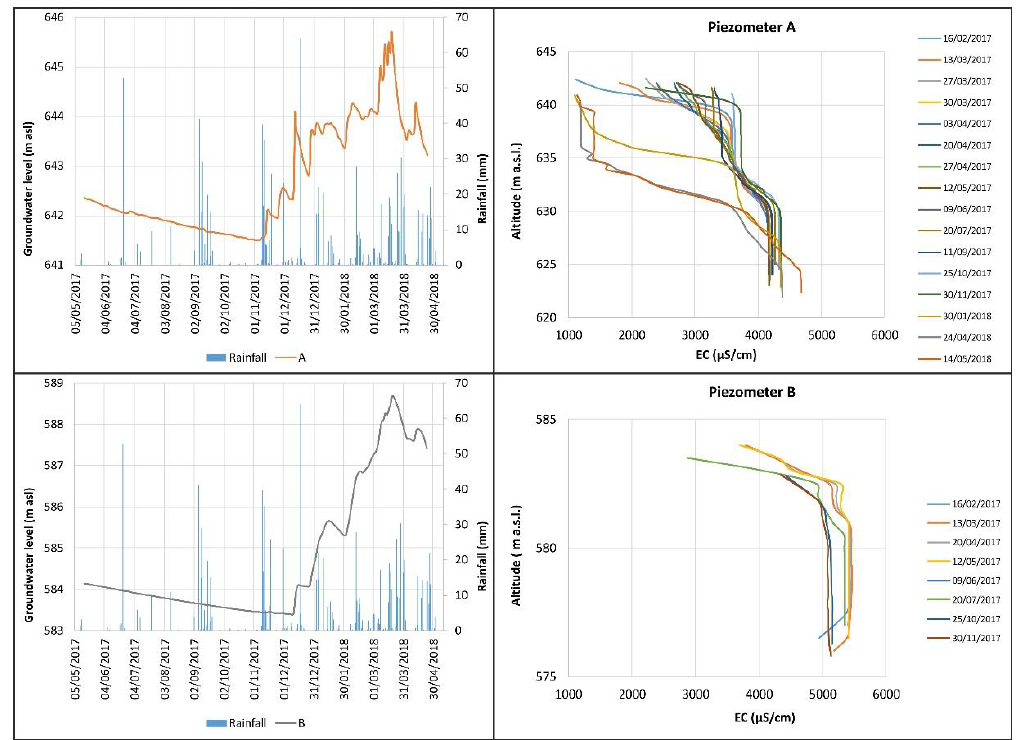
Figure 3. Hydraulic head fluctuations measured in piezometers A and B, and daily precipitation recorded at Mormorola station and the vertical profile of electrical conductivity (EC) in piezometers A and B.